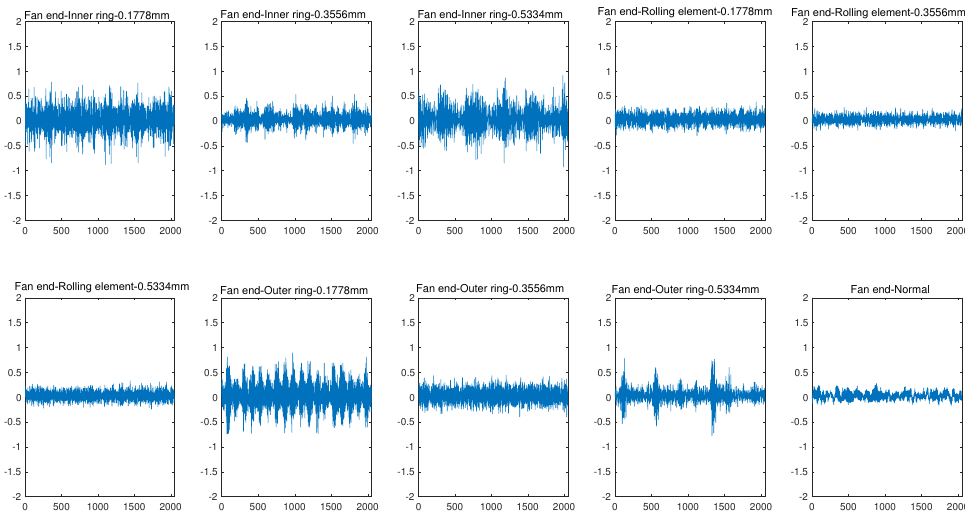
Figure 2. Time frequency diagram of failure samples at fan end.